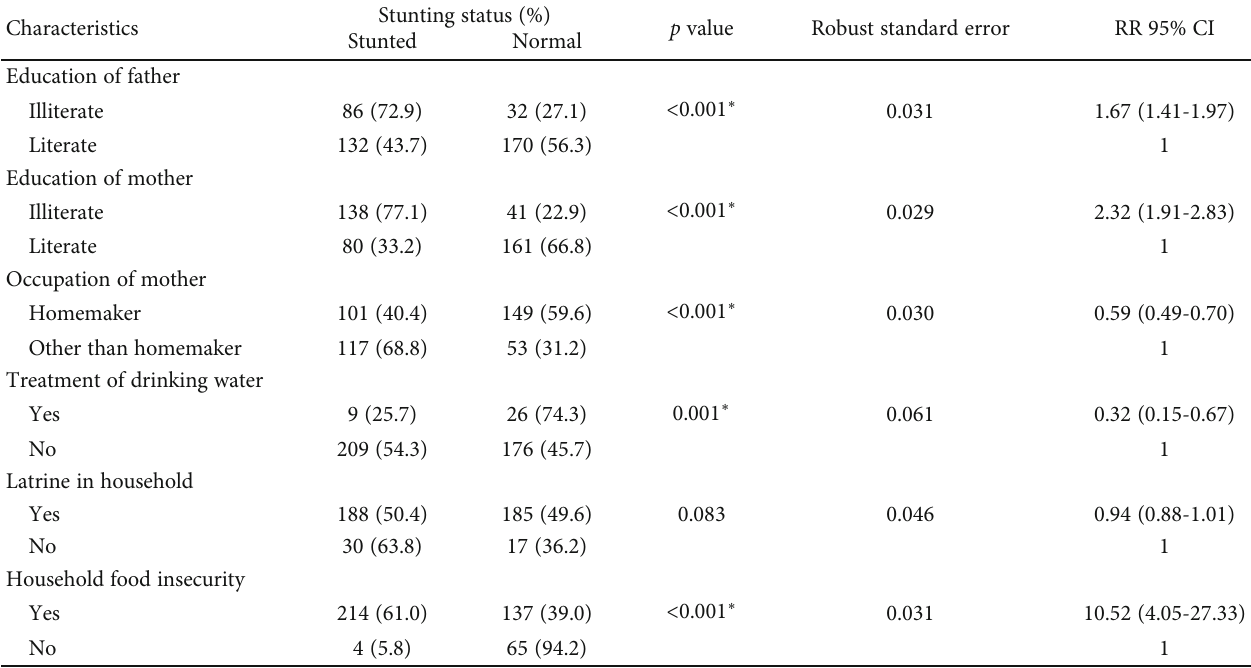
Table 6: Factors associated with stunting in using log-binomial regression